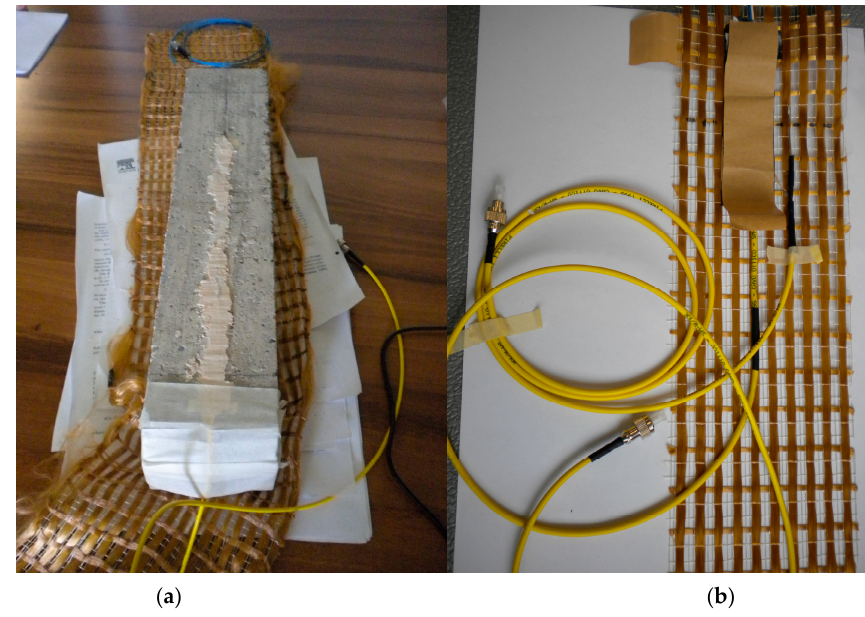
Figure 1. ( a ) Post-cured concrete beam with embedded FBG; ( b ) PBO reinforcing woven instrumented with FBGs and electrical strain gauge (before